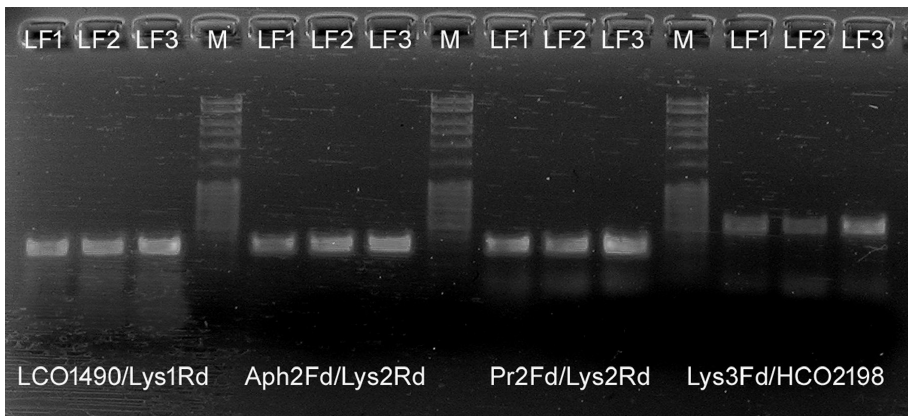
Figure 5. Agarose gel visualizing the products of direct PCR in initial trials testing the novel primers with fresh Lysiphlebus samples. Tested combinations of primers were: 1) LCO1490/Lys1Rd; 2) Aph2Fd/ Lys2Rd; 3) Pr2Fd/Lys2Rd; and 4) Lys3Fd/HCO2198. The species included in trials were: LF1 - L. hirti- cornis ; LF2 - L. cardui ; and LF3 - L. fabarum ; M –